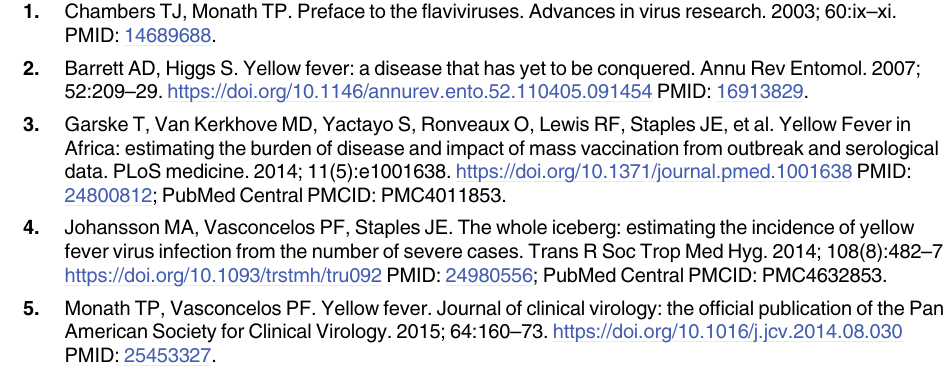
S2 Table. Seasonal models and their coefficient estimates (95% CIs). S3 Table. Model covariates for the annual model. S4 Table. Model covariates for the seasonal model. S1 Movie. Seasonal variation in covariates and predictions. A) Presence/absence of yellow fever reports (1971–2015) that fit inclusion criteria on a monthly scale, B) monthly